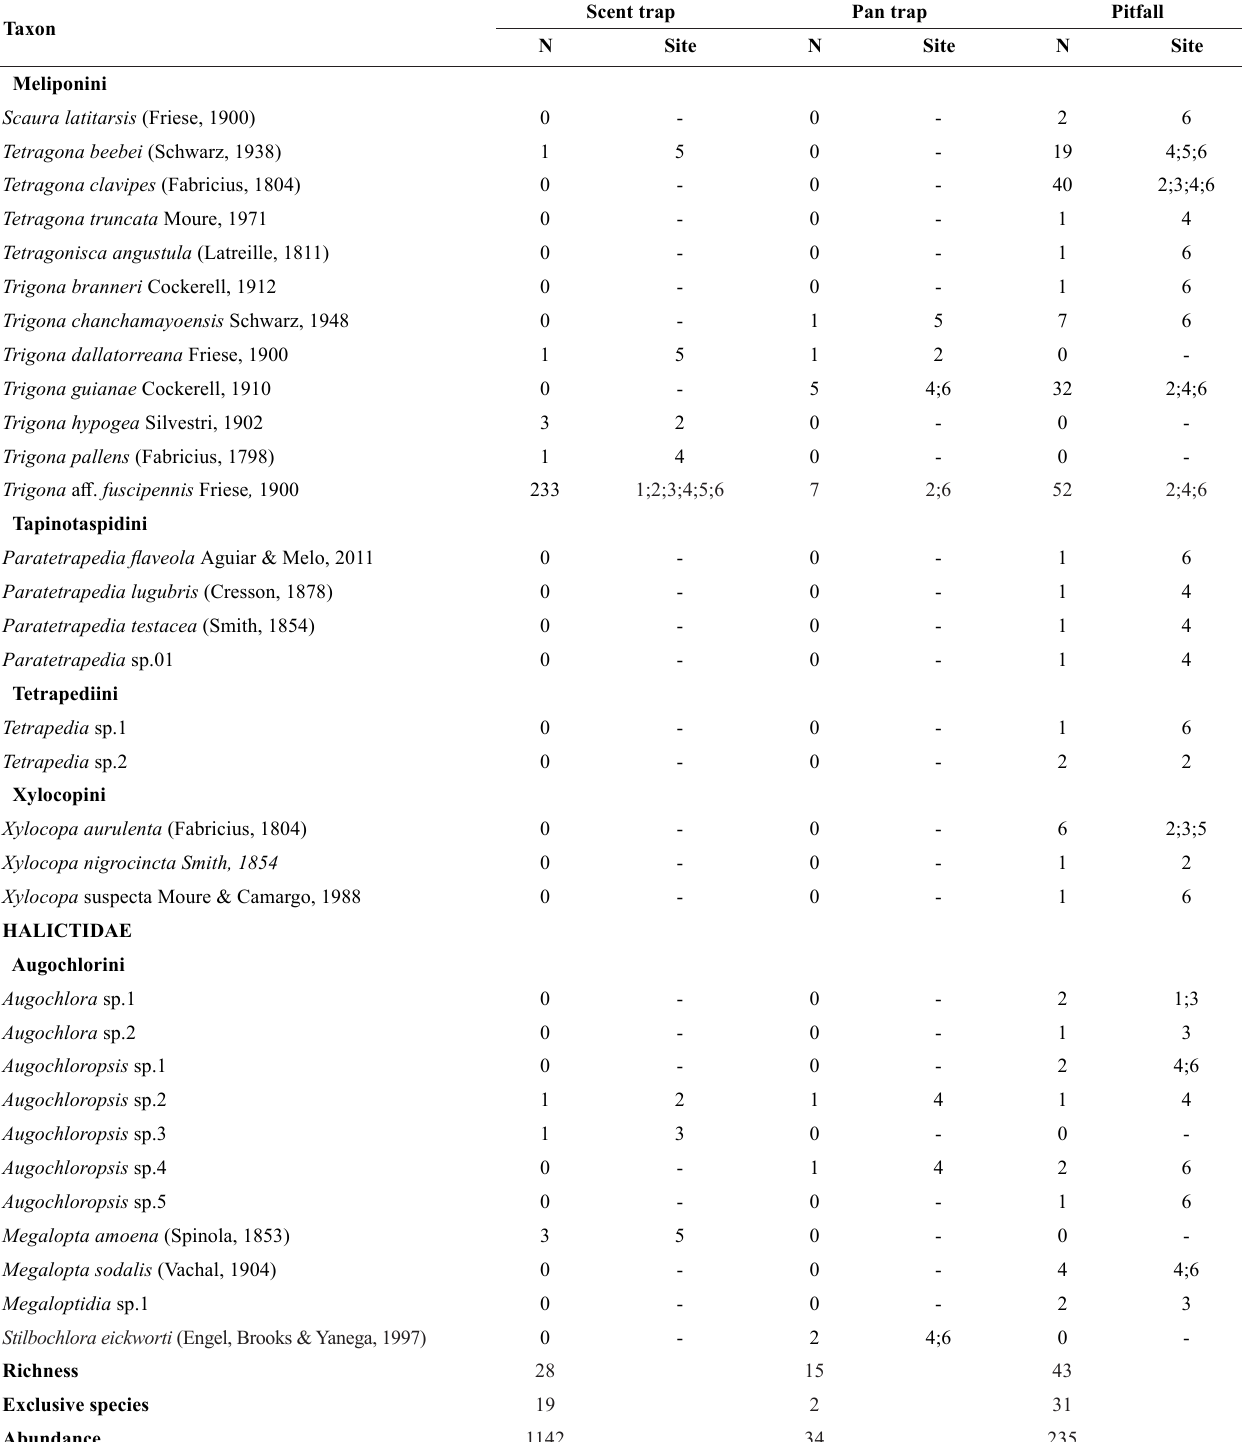
Table 1 . List of bee species sampled in six sites and using three different traps (arboreal pitfalls with urine, scent trap and pan traps) in a Cerrado and Amazon Forest ecotone in the municipality of Conceição do Araguaia, southeast of Pará, Brazil. (N = Abundance of bees). (Continuation)